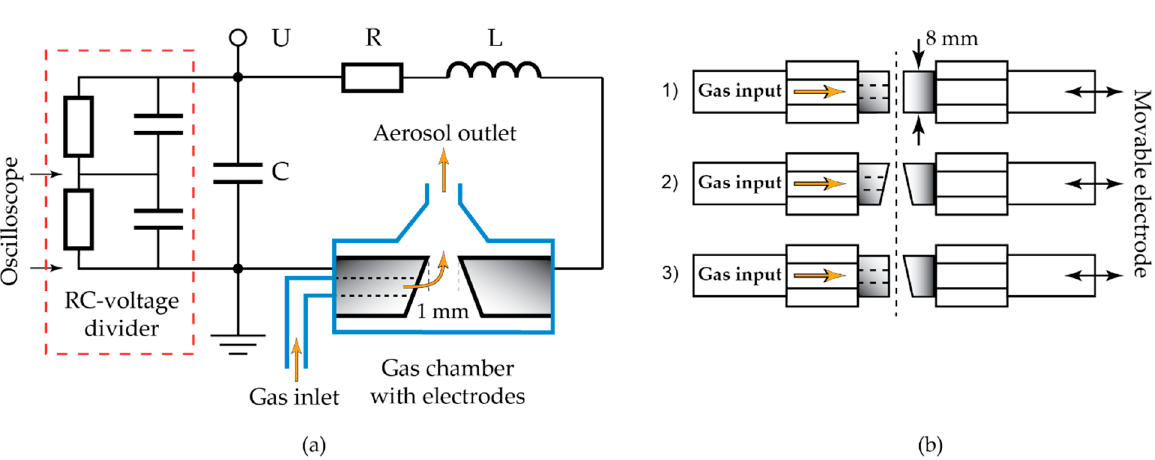
Figure 1. Equivalent representation of ( a ) the SDG setup and ( b ) of electrodes with the different position of their ends: ( 1 ) installed in parallel and at an angle for the experiments with ( 2 ) the ODP and ( 3 ) the UDP.